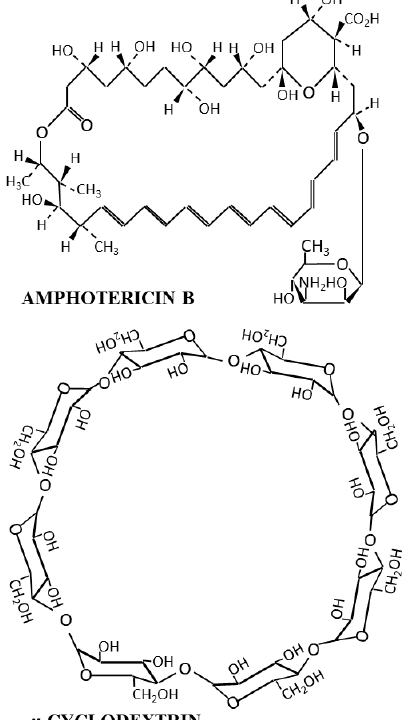
Figure 1. Chemical structure of AmB and γ -cyclodextrin.